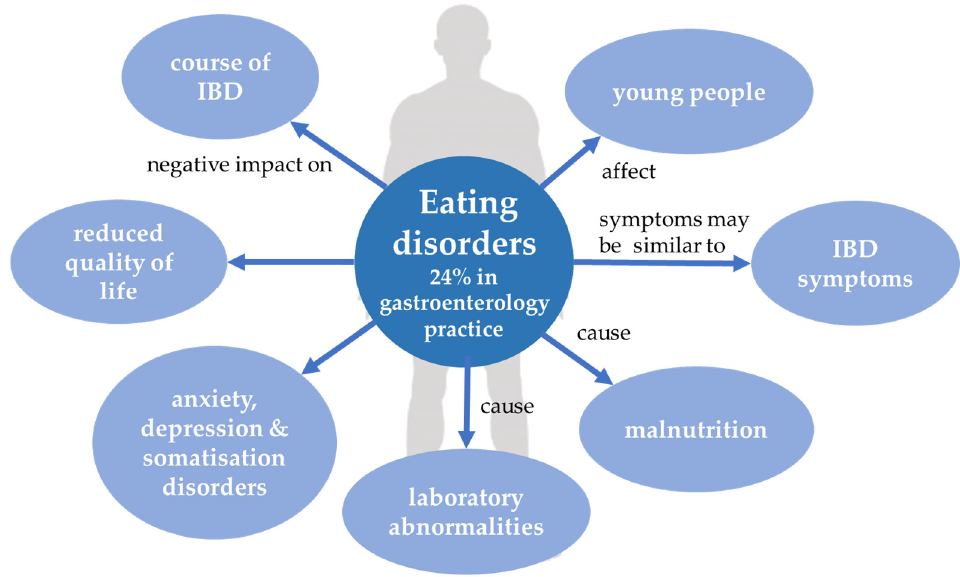
Figure 2. Eating disorders and inflammatory bowel disease. IBD, inflammatory bowel disease.